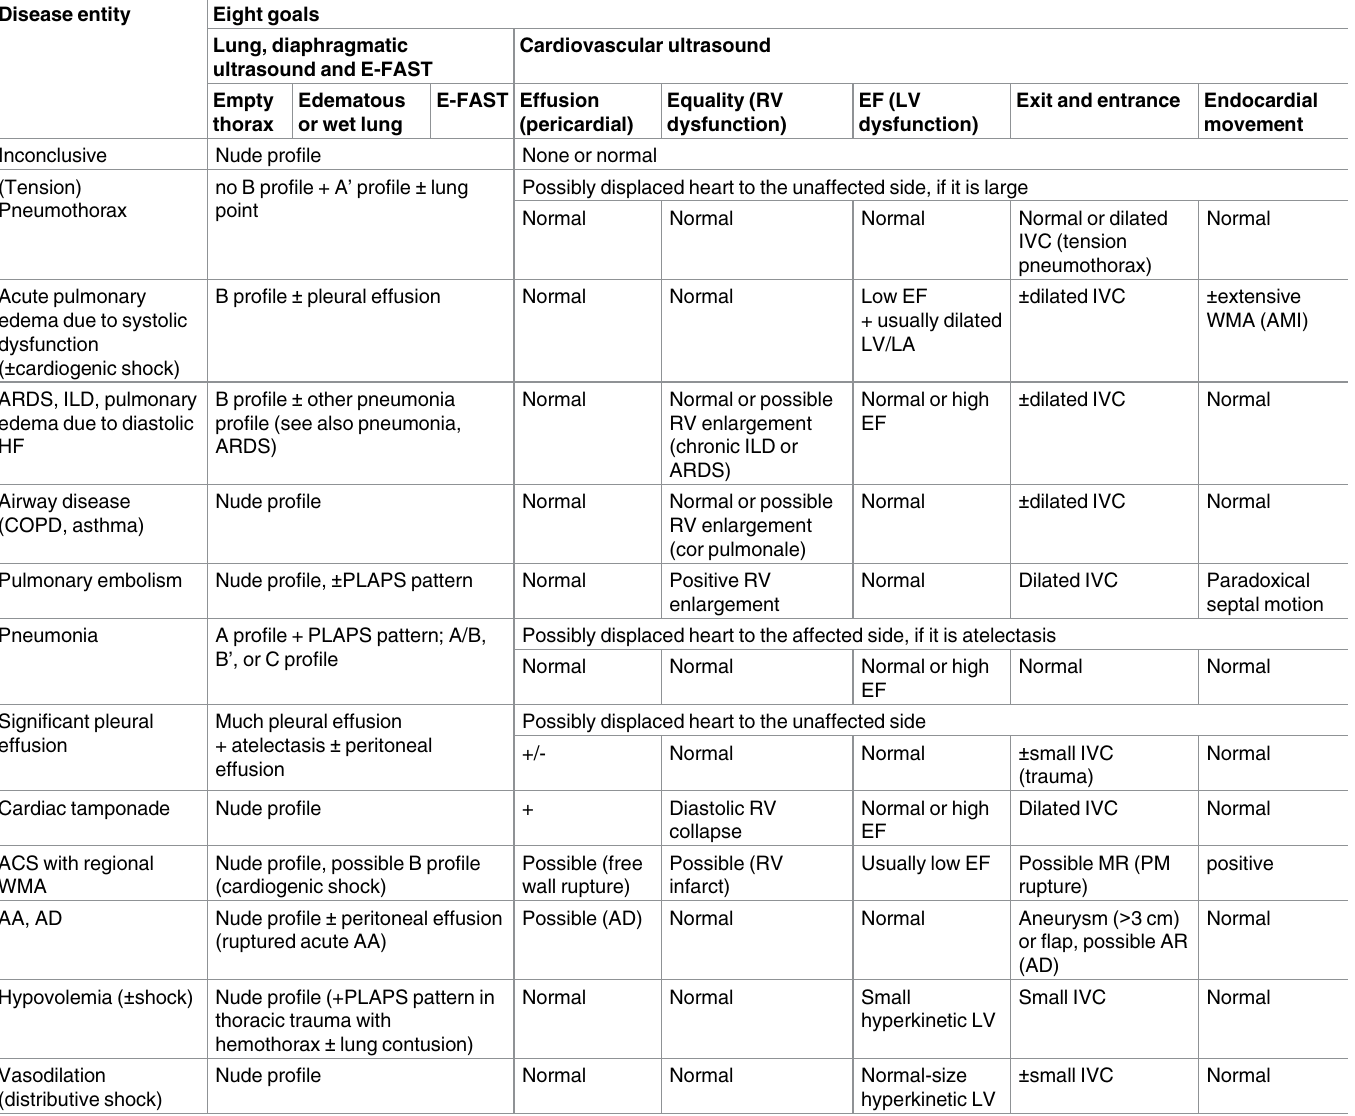
Table 1. Sonographic findings in each category of the SEARCH 8Es